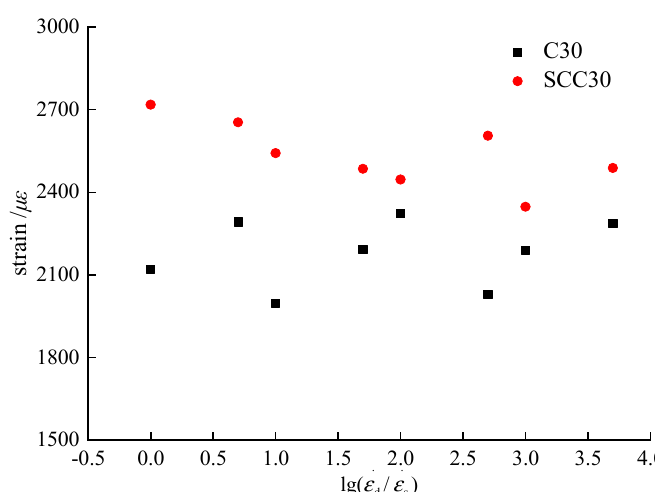
Figure 12. Relationship between strain rate and peak compressive strain.